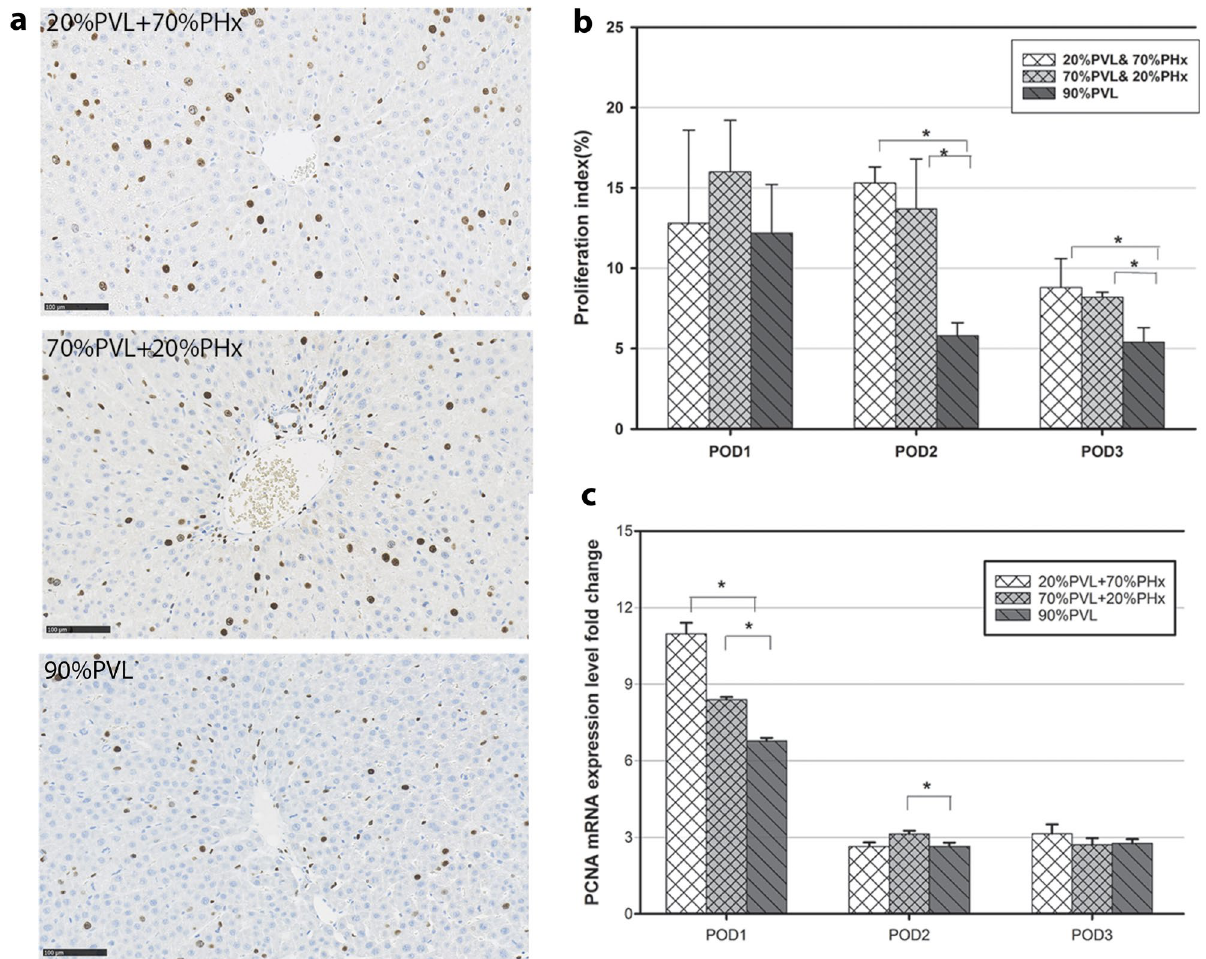
Figure 3. BrdU-staining, hepatocyte proliferation index (PI), PCNA mRNA expression level of the non-ligated FLR. ( a ) Immunohistochemistcal analysis of BrdU incorporation of non-ligated FLR on POD2. More BrdU- positive cells were observed after simultaneous PVL and PHx compared with PVL alone (Scale marker: 100 μm, magnification: ×200). ( b ) Proliferation index (PI) in the non-ligated FLR was significantly higher on POD2 after additional large PHx and additional small PHx compared with PVL alone (PI: 15% vs 6%, 12% vs 6%, * p value < 0.05). ( c ) PCNA mRNA expression level in the FLR was substantially increased after additional PHx compared with PVL alone (fold change: 11 vs 8.4 vs 6.7, * p <